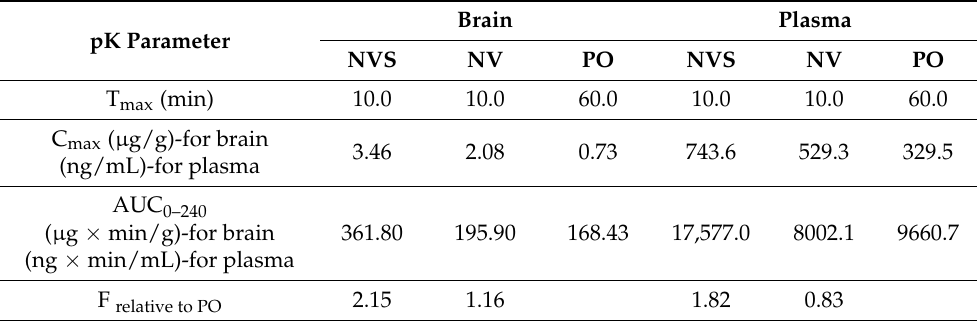
Table 5. Pharmacokinetic (pK) parameters for Tramadol in brain and plasma following administration in the nanovesicular system (NVS), Nasal non-vesicular system (NV) and Oral preparation (PO). pK